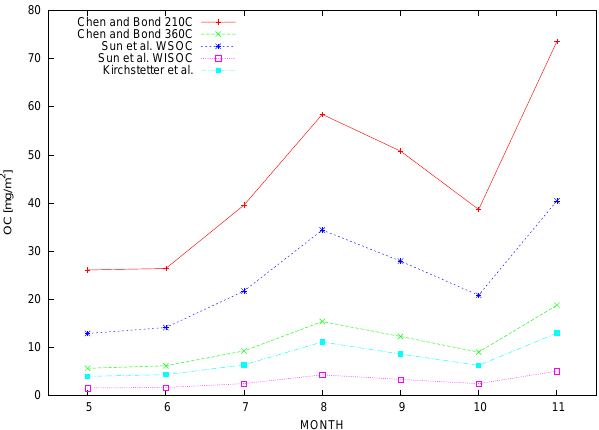
Fig. 5. Monthly mean absorbing OC [mgm − 2 ] for Mongu, as- suming different imaginary index values for OC. Kirchstetter et al. (2004) based values correspond to the retrievals presented in this paper. Sensitivity study was carried out applying also imaginary in- dex values presented in Chen and Bond (2010) for two production temperatures and in Sun et al. (2007) for water soluble (WSOC) and water-insoluble organic carbon